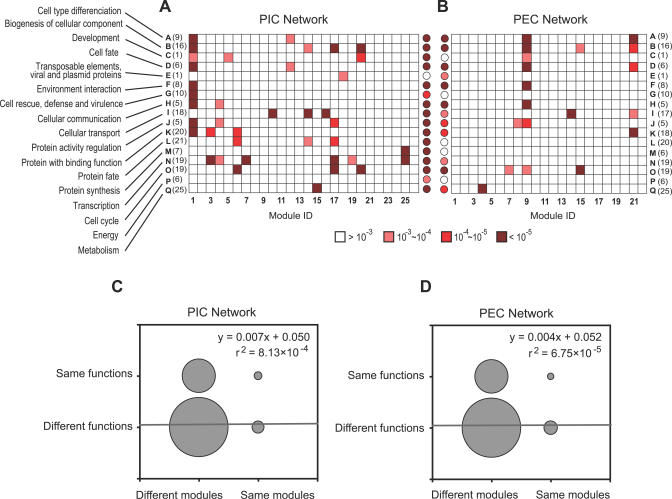
Lack of Obvious Correspondence between Structural Modules and Functional Units(A,B) Each functional category is indicated by a letter (A to Q). In parentheses next to the letter is the percentage of proteins in the network that belong to that functional category. Note that one protein may belong to more than one category. The circles next to the grid show the statistical significance of nonrandom distributions of genes of the same functional categories across modules. Each small square in the grid shows the statistical significance of enrichment of a particular function in a module. For the circles and squares, significance levels are indicated by different colors.(C,D) Show the correlation between co-membership in structural modules and co-functionality for all pairs of proteins in the PIC and PEC networks, respectively. The circle size is proportional to the number of protein pairs. The line shows the linear regression and r is the correlation coefficient.